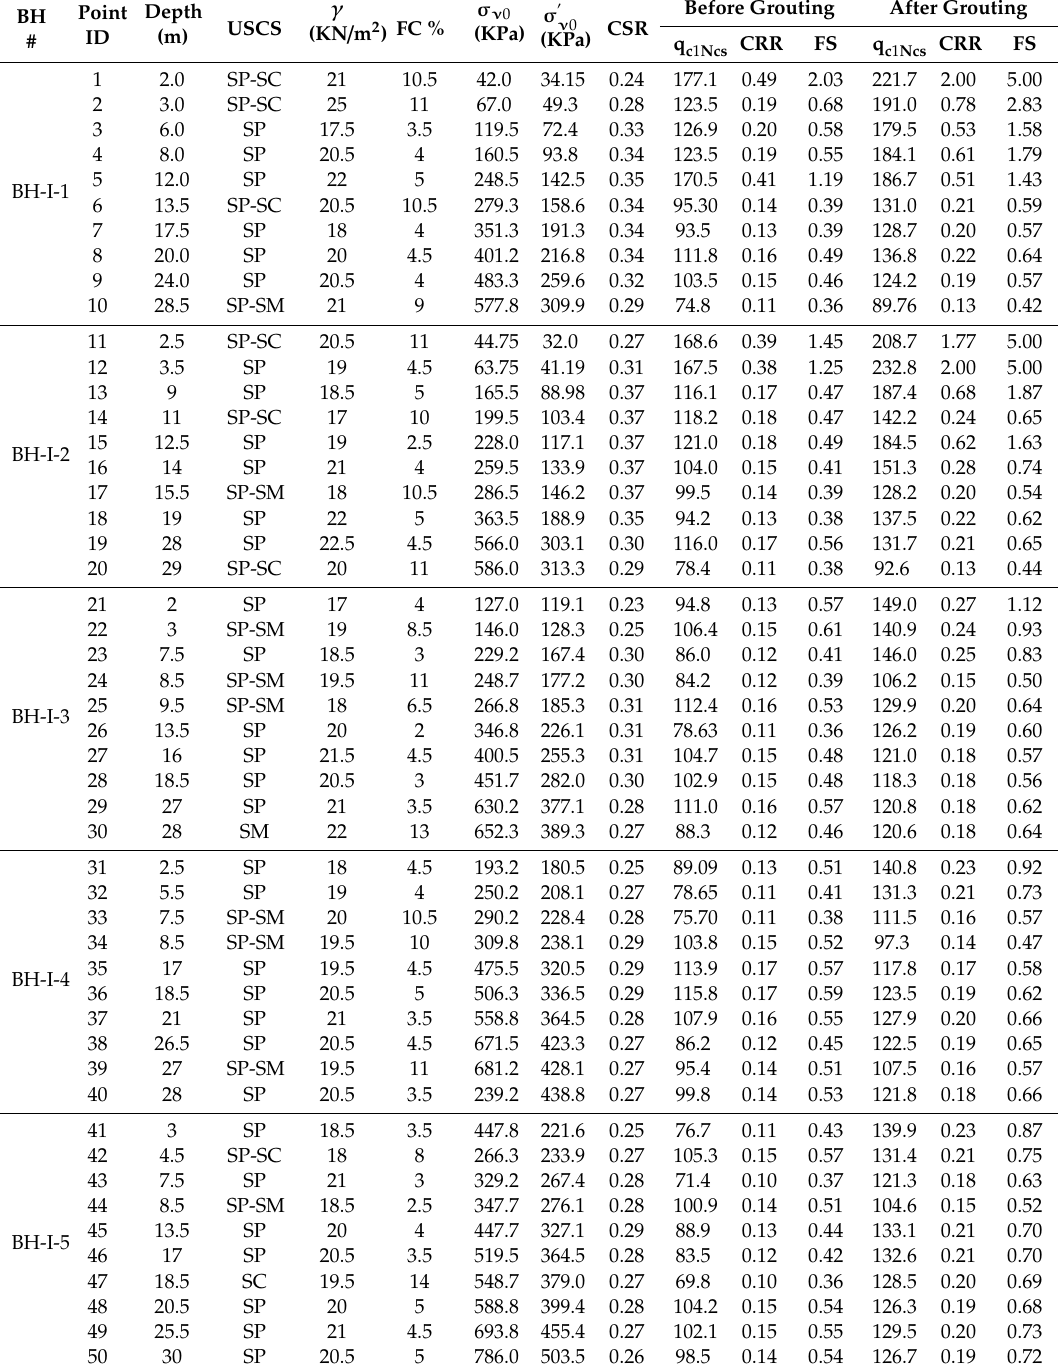
Table 1. CPT-based liquefaction triggering assessment prior to and after jet grouting using micropiles following the Boulanger and Idriss